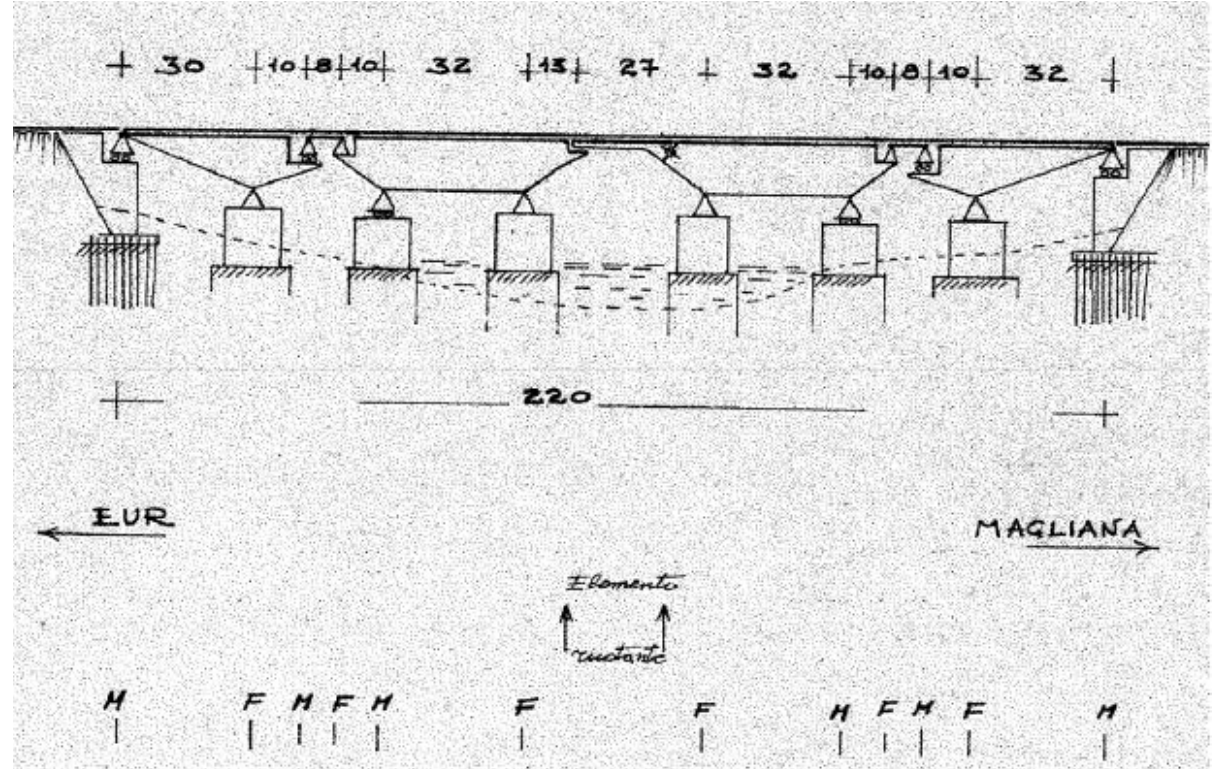
Figure 4. Original static scheme of the bridge (found in [25]).